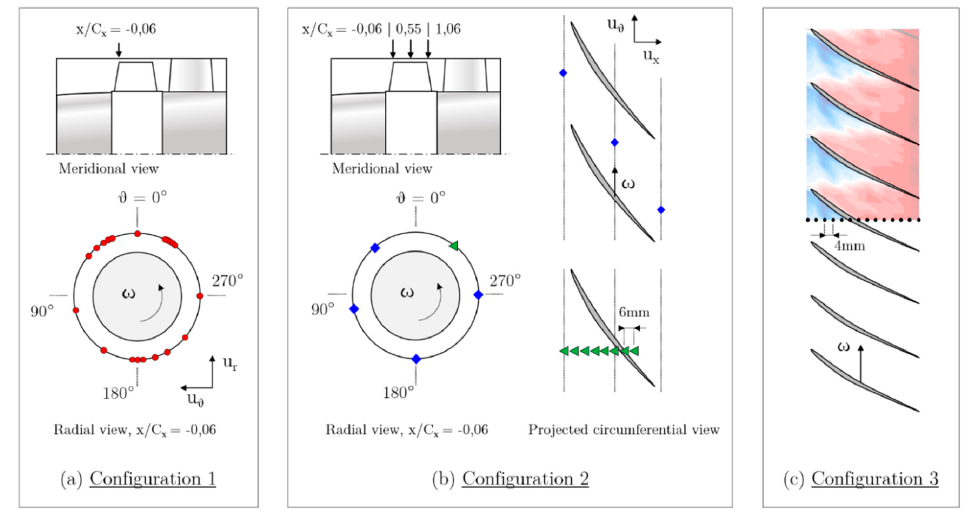
Figure 3. Pressure transducer locations.